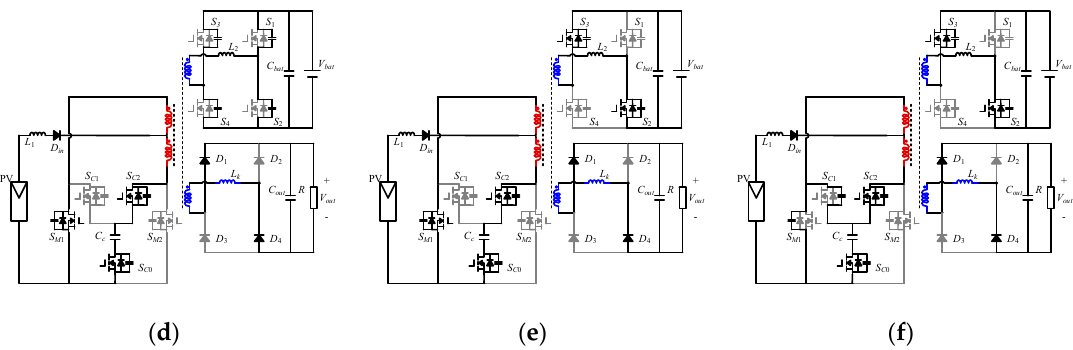
Figure 3. Equivalent circuits of the operation modes with PV source: ( a ) Mode 1 ( t 0 – t 1 ); ( b ) Mode 2 ( t 1 –